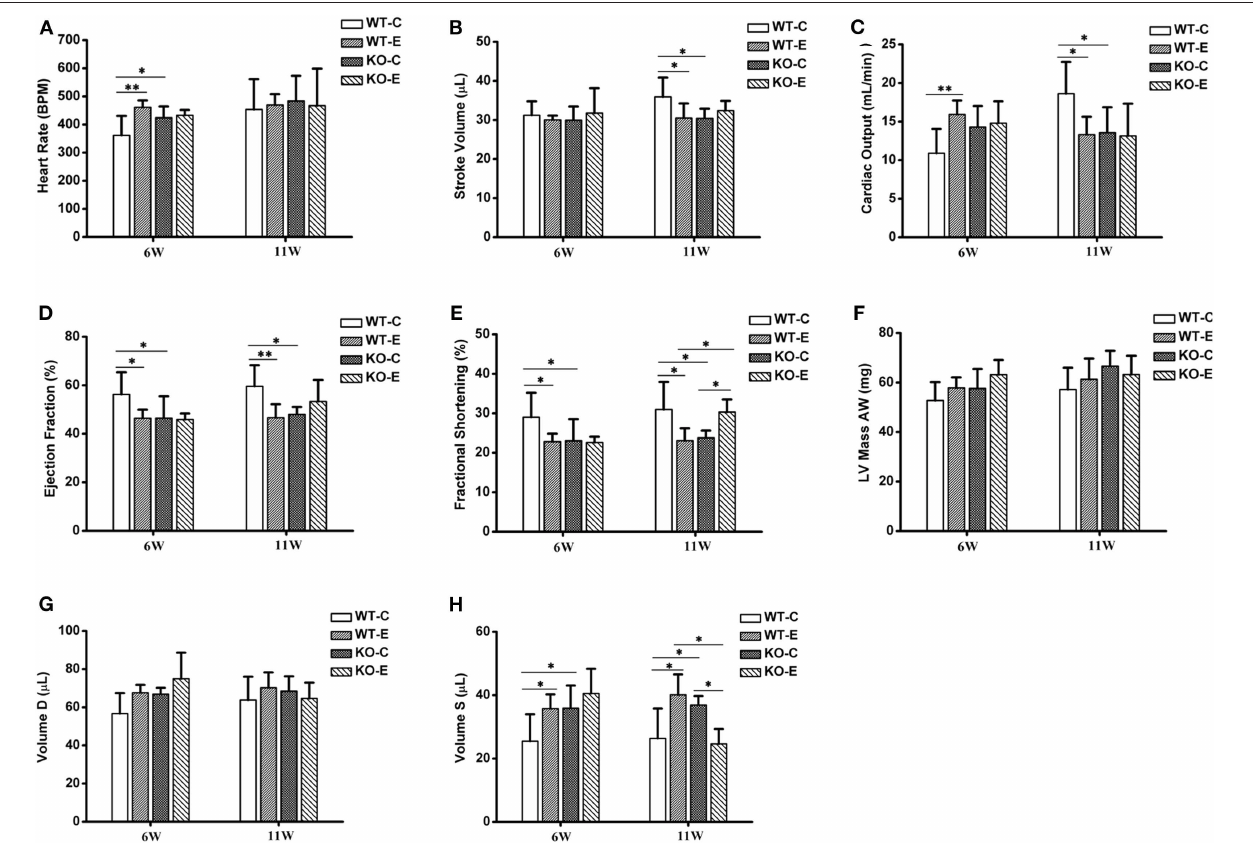
FIGURE 1 | Echocardiography results. For 6 or 11 weeks, 6–8-weeks C57/B6 mice, with or without Nrf2 knockout, were exposed to either filtered air or air containing particulate matter (PM). The animals were then anesthetized with 80 mg/kg pentobarbital via intraperitoneal injection and subjected to a Vevo 2,100 imaging system for echocardiography. N = 4–5 per group. WT-C, wildtype control; WT-E, wildtype exposed. KO-C, knockout control; KO-E, knockout exposed. *Statistically different between the two groups ( P < 0.05). **Statistically different between the two groups ( P < 0.01). (A) Quantitative results for heart rate. (B) Quantitative results for stroke volume. (C) Quantitative results for cardiac output. (D) Quantitative results for ejection fraction. (E) Quantitative results for fractional shortening. (F) Quantitative results for LV mass AW. (G) Quantitative results for Volume D. (H) Quantitative results for Volume